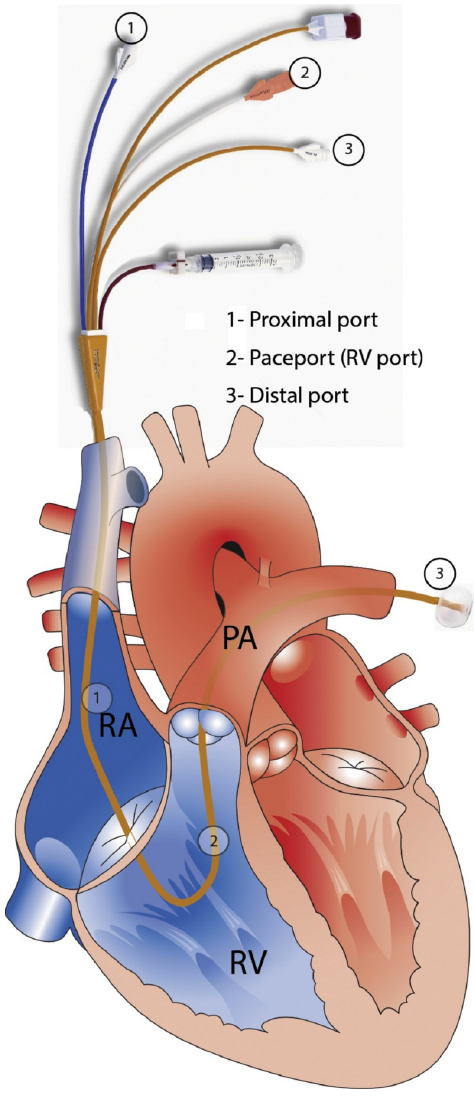
Fig 1. Schematic representation of the position of a pulmonary artery catheter capable of right ventricular pressure monitoring inside the right heart (Thermodilution Paceport Pulmonary Artery Catheter, product reference 931F75, Edwards Lifesciences, Irvine, CA). PA, pulmonary artery; RA, right atrium; RV, right ventricle. From Raymond M, Gr ø nlykke L, Couture EJ, et al. Perioperative Right Ventricular Monitoring in Cardiac Surgery. J Cardiothorac Vasc Anes 2019;33:1090–104. Figure used with